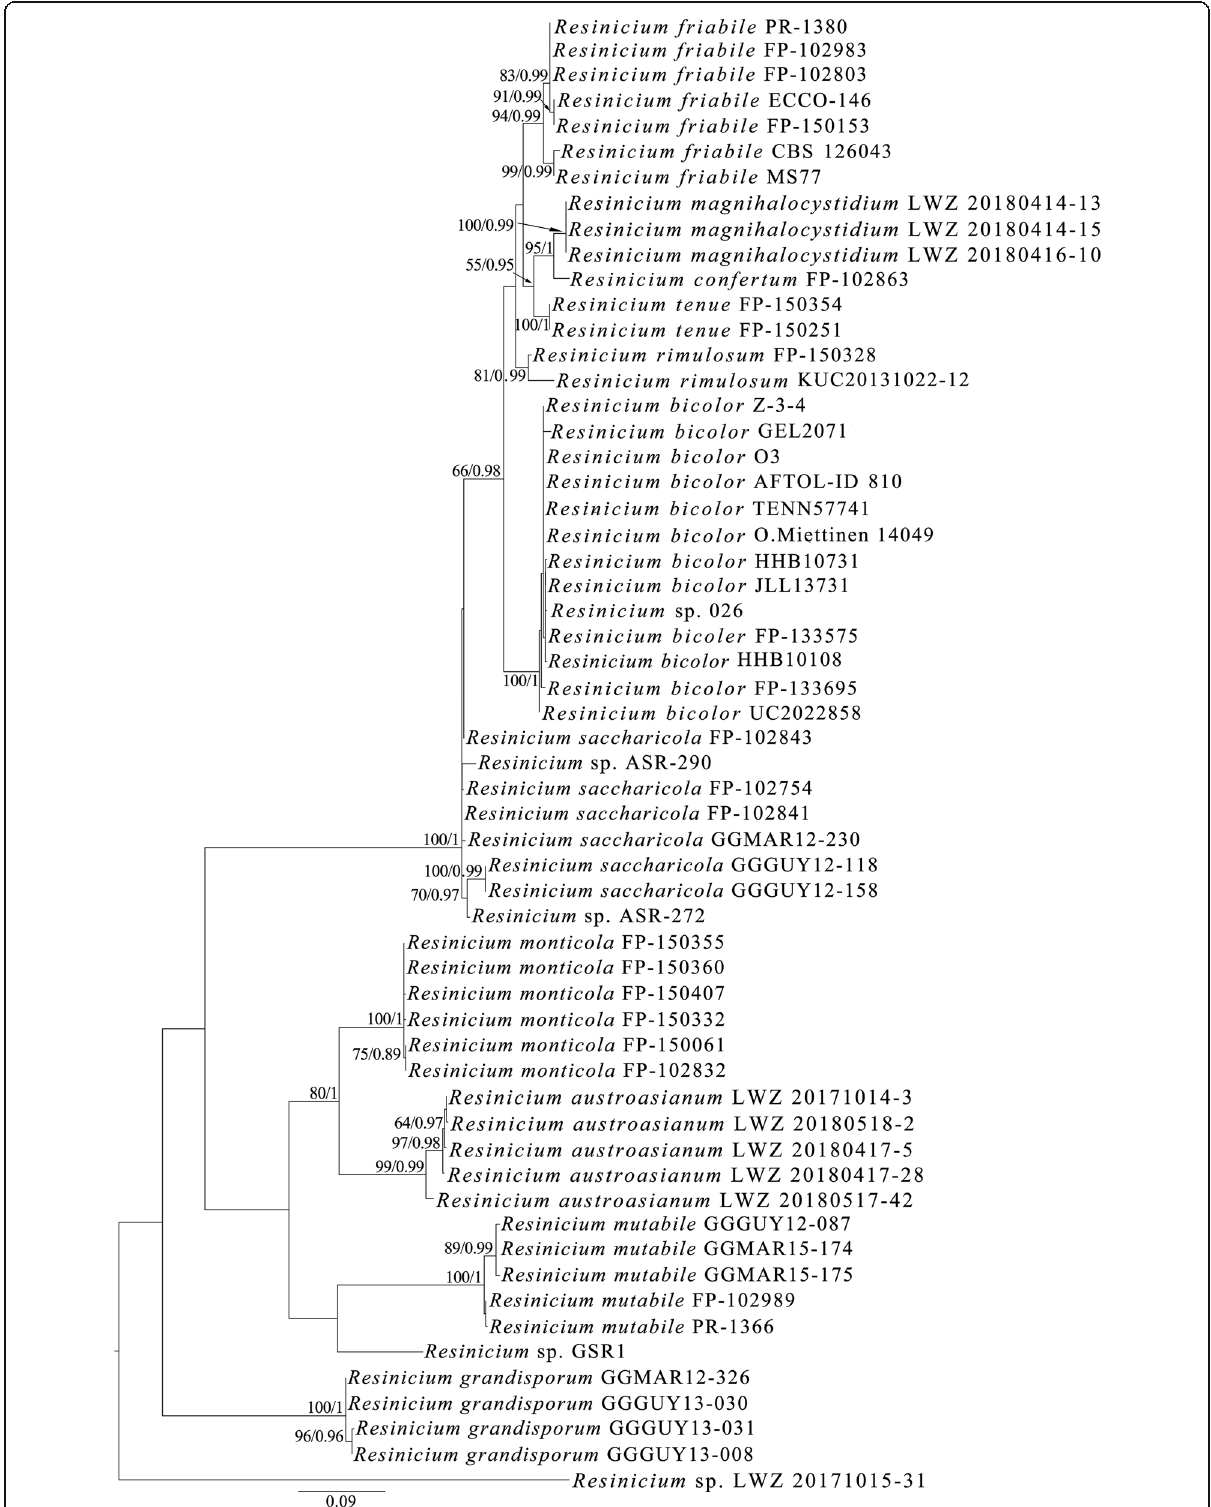
Fig. 2 Species identities of Resinicium differentiated by ITS-based phylogeny. The midpoint-rooted tree generated by the maximum likelihood method is presented along with the bootstrap values and the Bayesian posterior probabilities above 50% and 0.8, respectively, at the